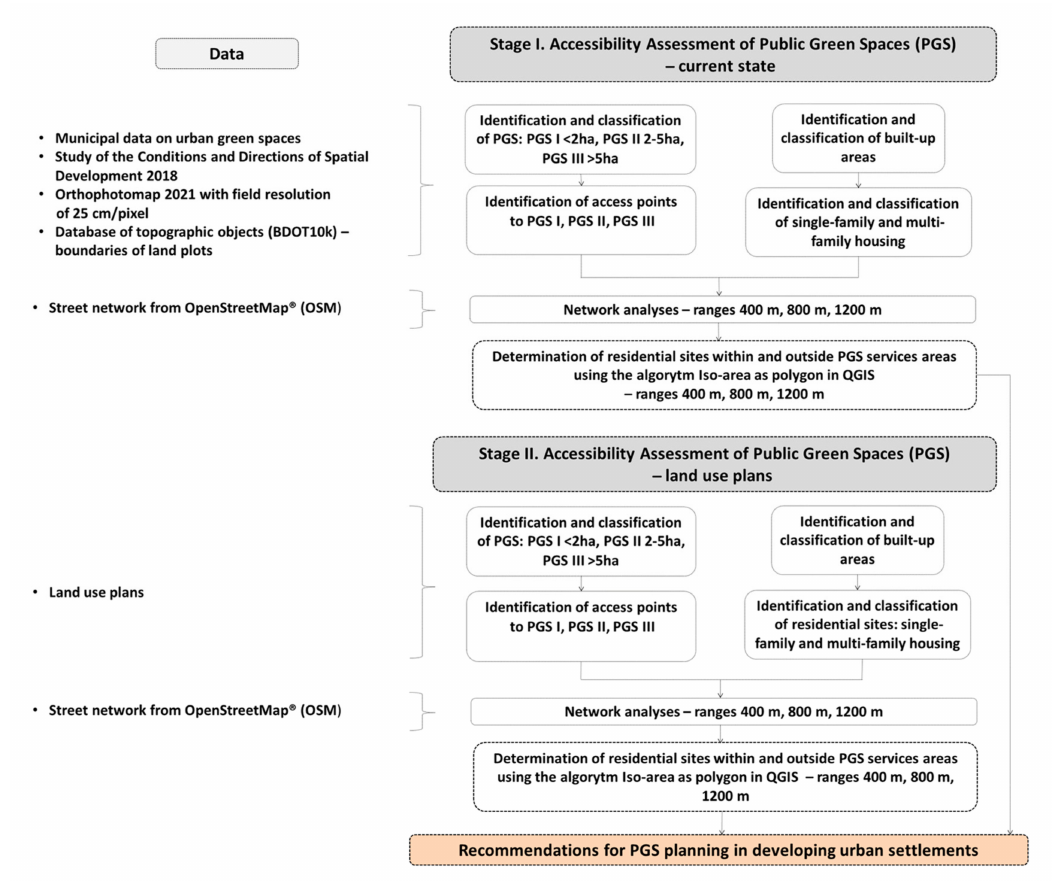
Figure 2. The flowchart of the